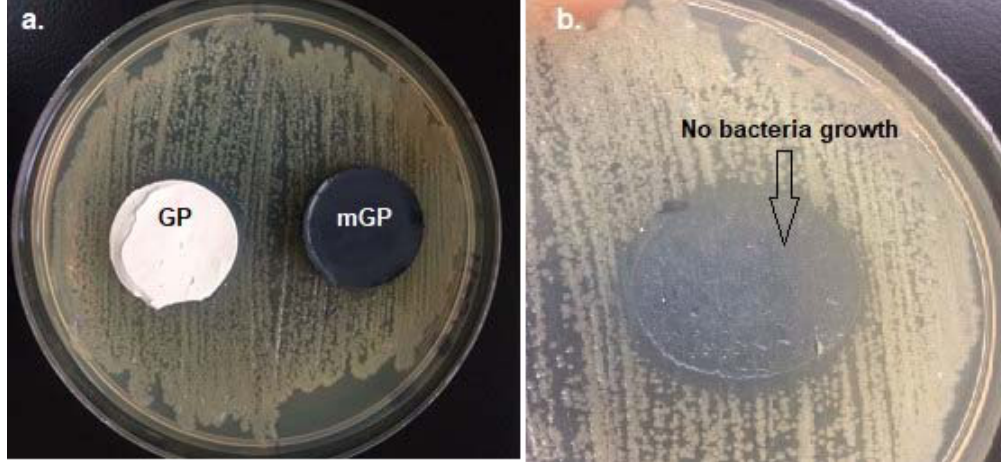
Figure 8. Standardization test for Escherichia coli : ( a ) GP (10 wt.% TiO 2 ) and mGP (5 wt.% CuO); ( b ) inhibition of growth of bacteria under GP sample. Table 4. Results of the first bactericidal test phase: standardization method.